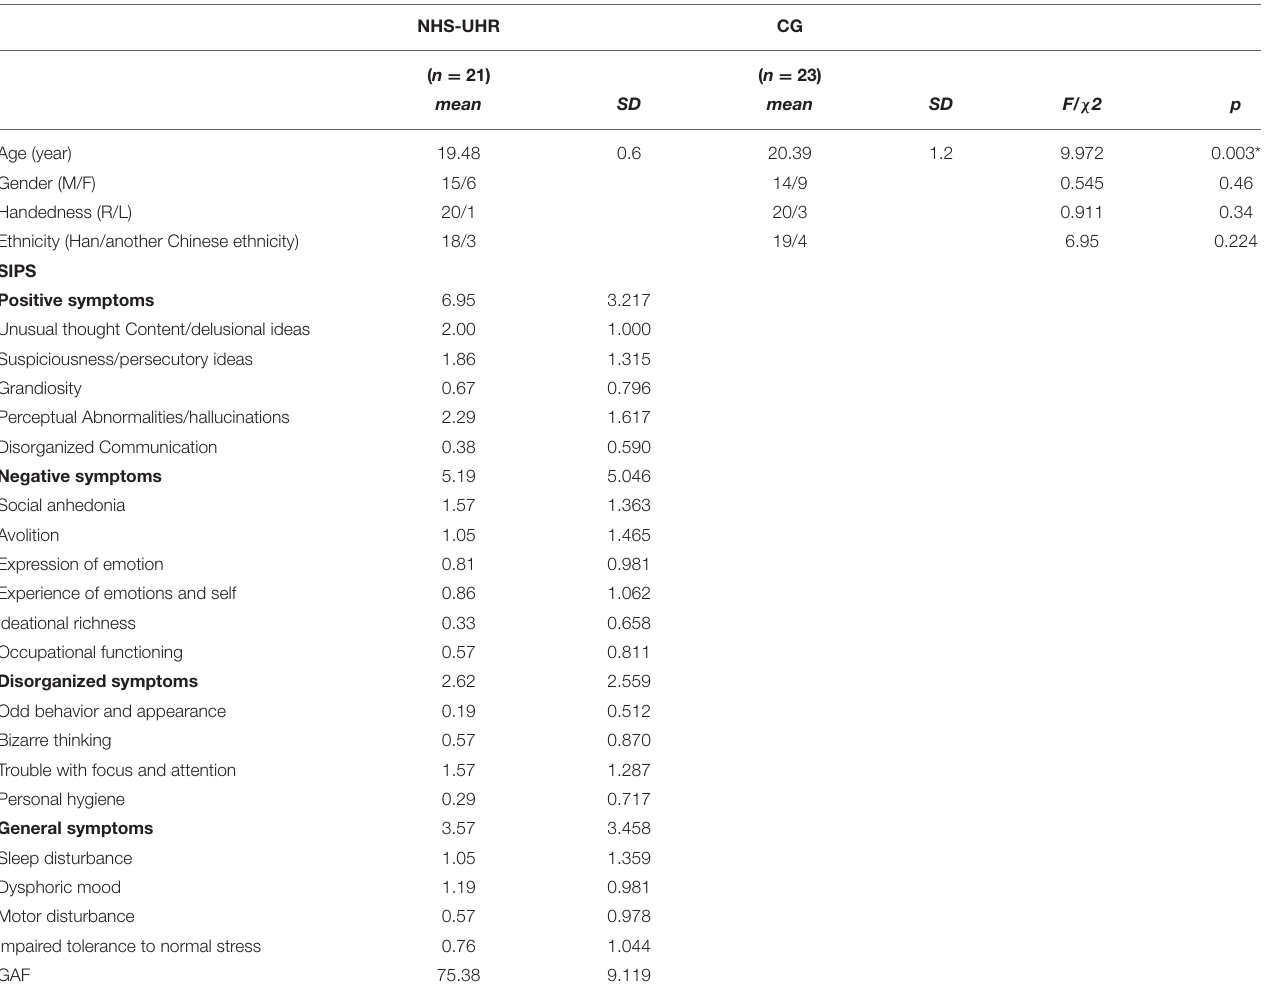
TABLE 1 | Sociodemographic characteristics and clinical symptoms in high-functioning high-risk psychosis (NHS-UHR) and control group